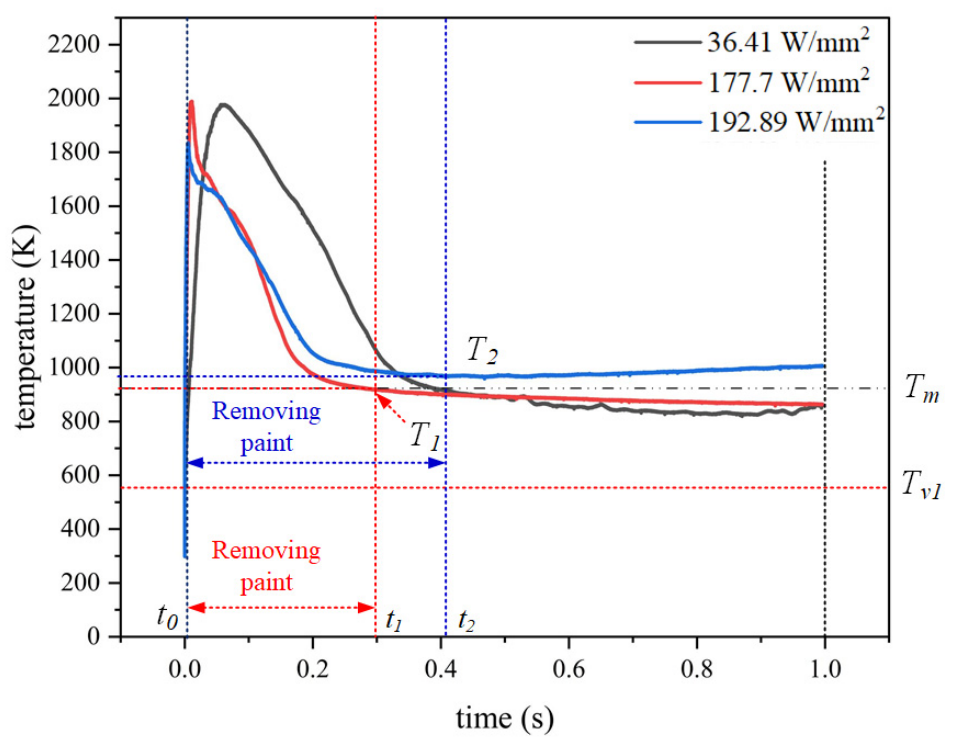
Figure 2. Temperature change of the epoxy primer during paint removal.